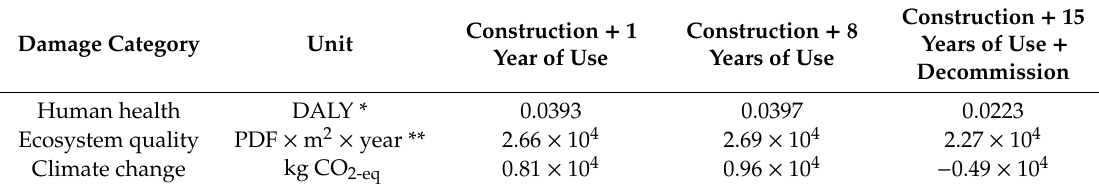
Table 3. The environmental footprint of the 500-kW heat output Stirling cycle HP for construction, use and end-of-life decommissioning.